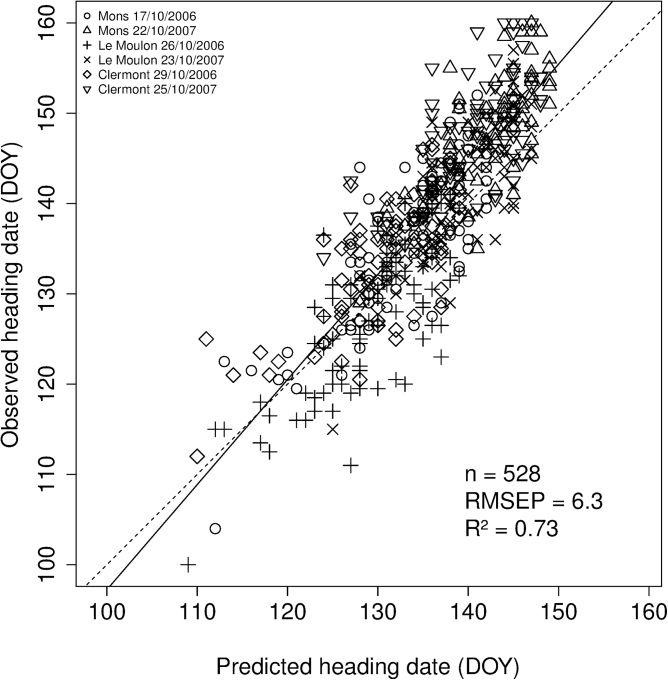
Relationships between observed heading dates and heading dates predicted with two QTL-based parameters (2p strategy) using a modified version of the Weir et al. (1984) phenological model for the validation data set comprising 88 independent wheat genotypes grown in six independent location × sowing date combinations. Linear regression (solid) and bisecting (dashed) lines are shown. The number of datapoints (n), the percentage of variance explained (R2), and the RMSEP are indicated.